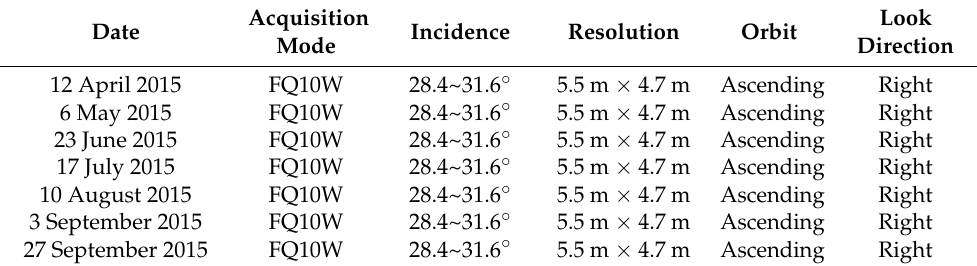
Table 1. Description of available RADARSAT-2 time series overpassed the study area in